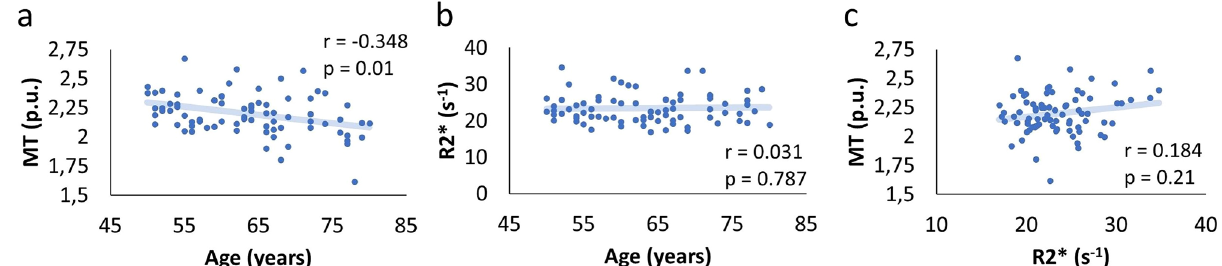
Figure 6. Relationship between MT, R2*, and age within the SN/VTA. We observed a significant negative correlation between MT and age ( a ); but no significant correlations between ( b ) R2* and age or ( c ) MT and R2* (p > 0.05). Benjamini-Hochberg (FDR) p-value adjustment was applied.